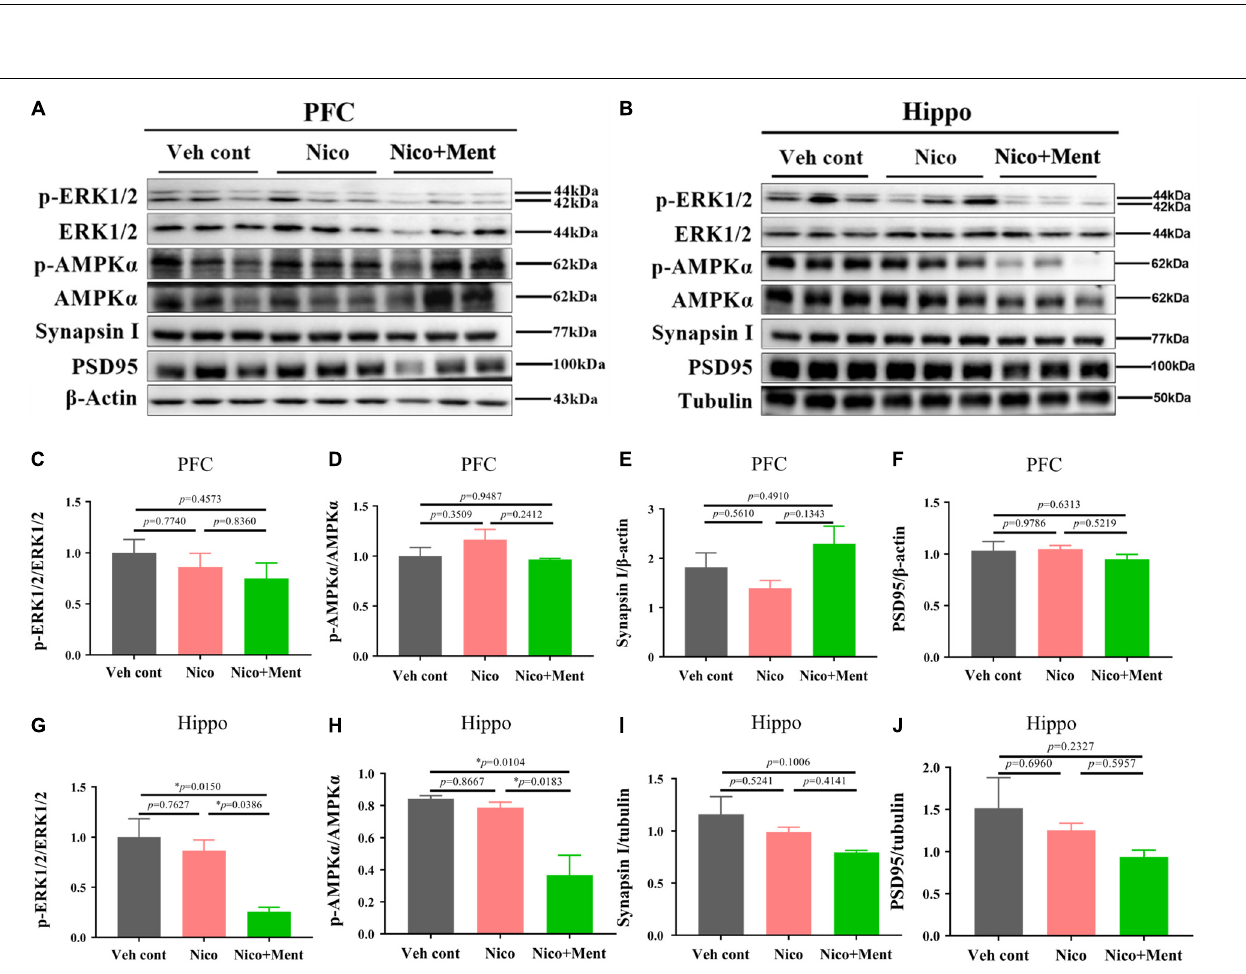
FIGURE 7 | The immunometabolic signals and synaptic protein analyses in the PFC/hippocampus of mice after long-term vapor exposure. Western blot analyses of the expressions of p/t-ERK1/2, p/t-AMPK α , synaptic proteins, such as Synapsin-1 and PSD95 in the PFC (A) and the hippocampus (B) . The quantification data of the above molecules are presented in (C–J) , respectively. Data are expressed as means ± SEM. The values of ∗ p < 0.05 as determined by ordinary one-way ANOVA and multiple comparisons with every other group. Veh cont, Vehicle control; Nico, Nicotine; Nico + ment, nicotine with menthol flavor.